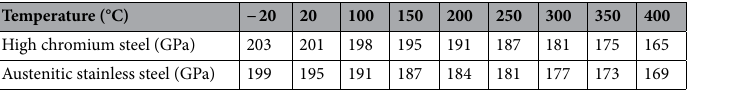
Table 2. Elastic moduli at different